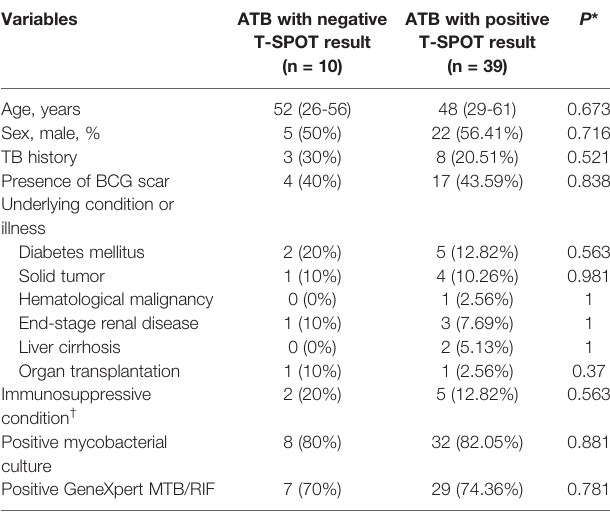
TABLE 2 | Demographic and clinical characteristics of ATB patients with negative and positive T-SPOT results. Variables